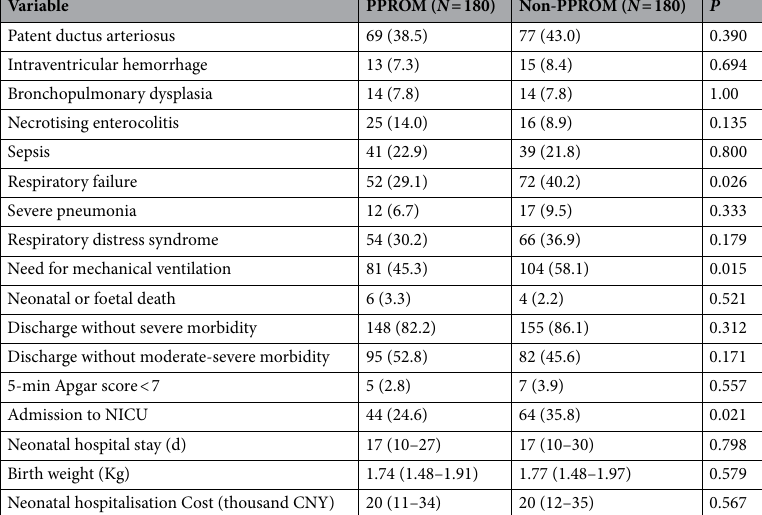
Table 4. Neonatal outcomes of twin pregnancies with PPROM by membrane status. Data are median (Q1-Q3) or N (%). GA gestational age, NICU neonatal intensive care unit, CNY China Yuan.